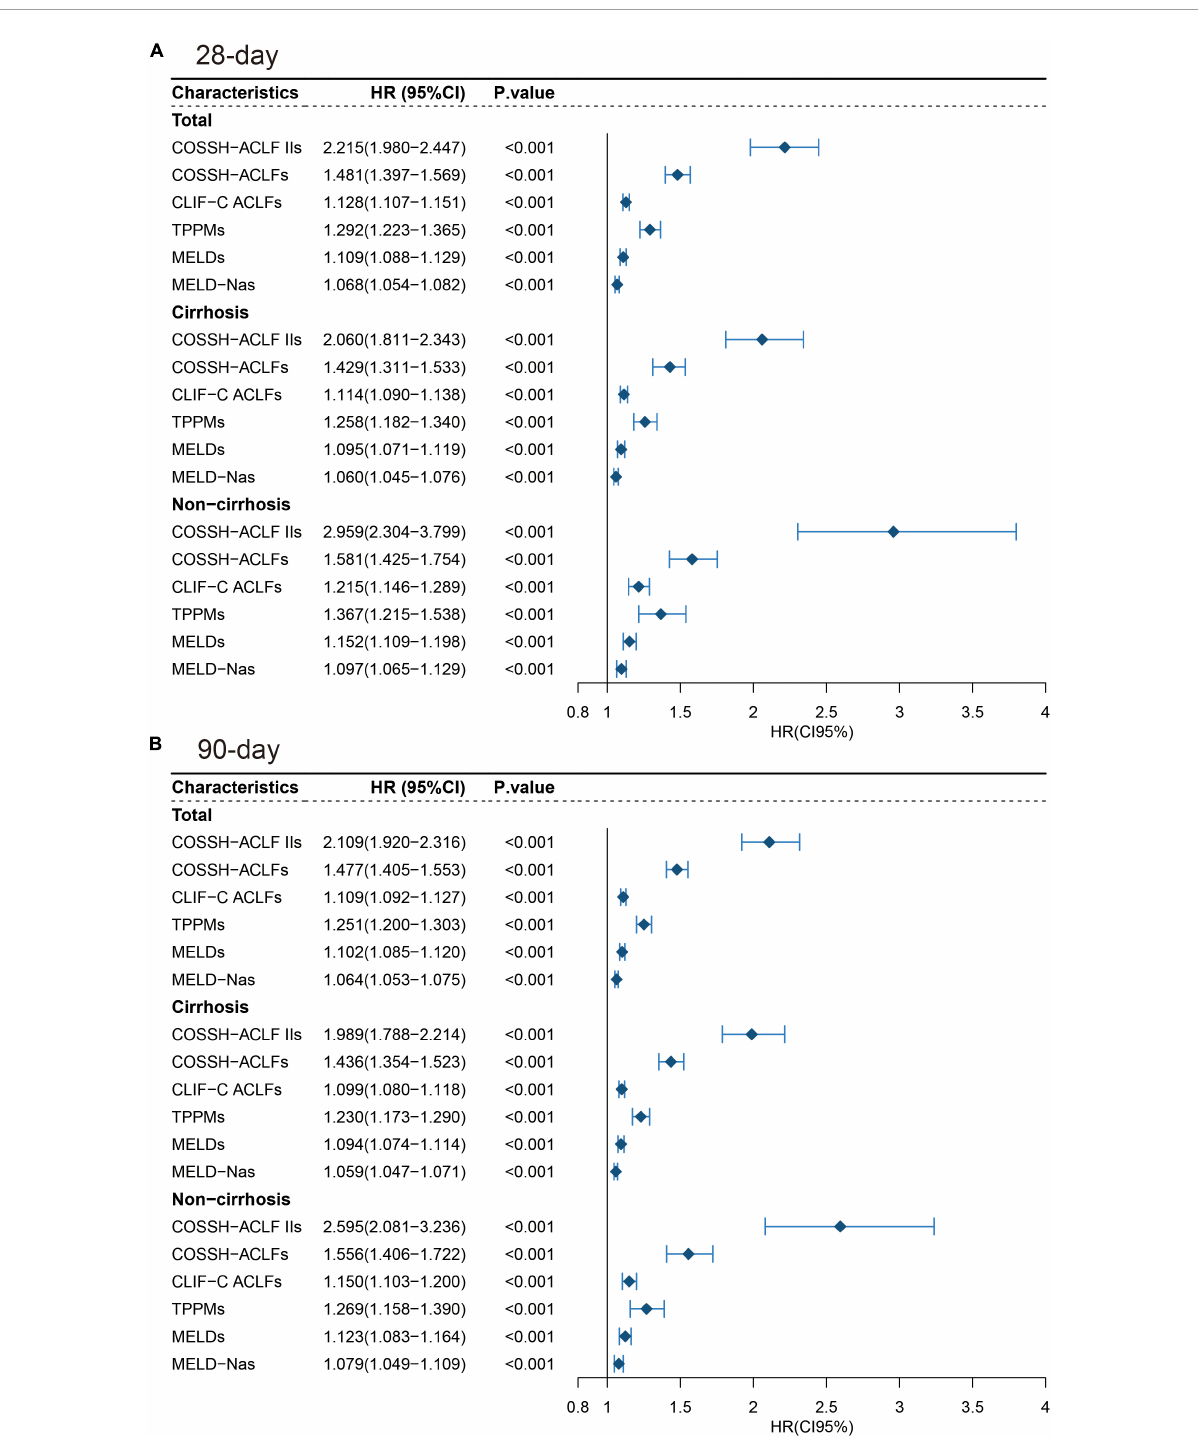
FIGURE3 Forest plot for prognostic scores of subgroups of HBV-ACLF. (A) 28-day and (B) 90-day.